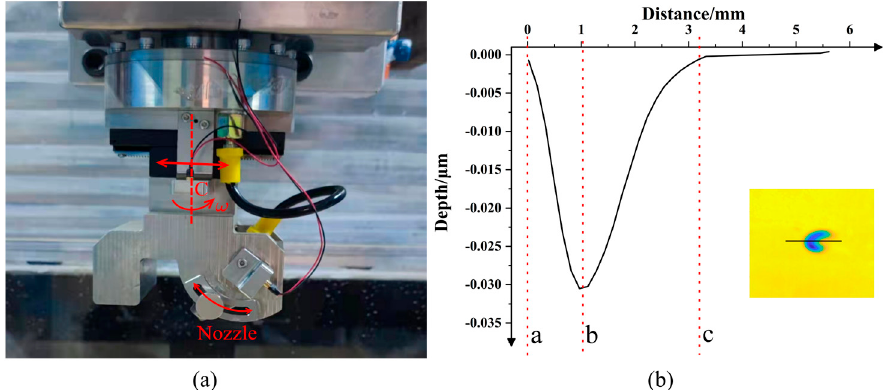
Figure 10. ( a ) An AWJP device; ( b ) the section curve of the TIF obtained when the nozzle was tilted at 60°.